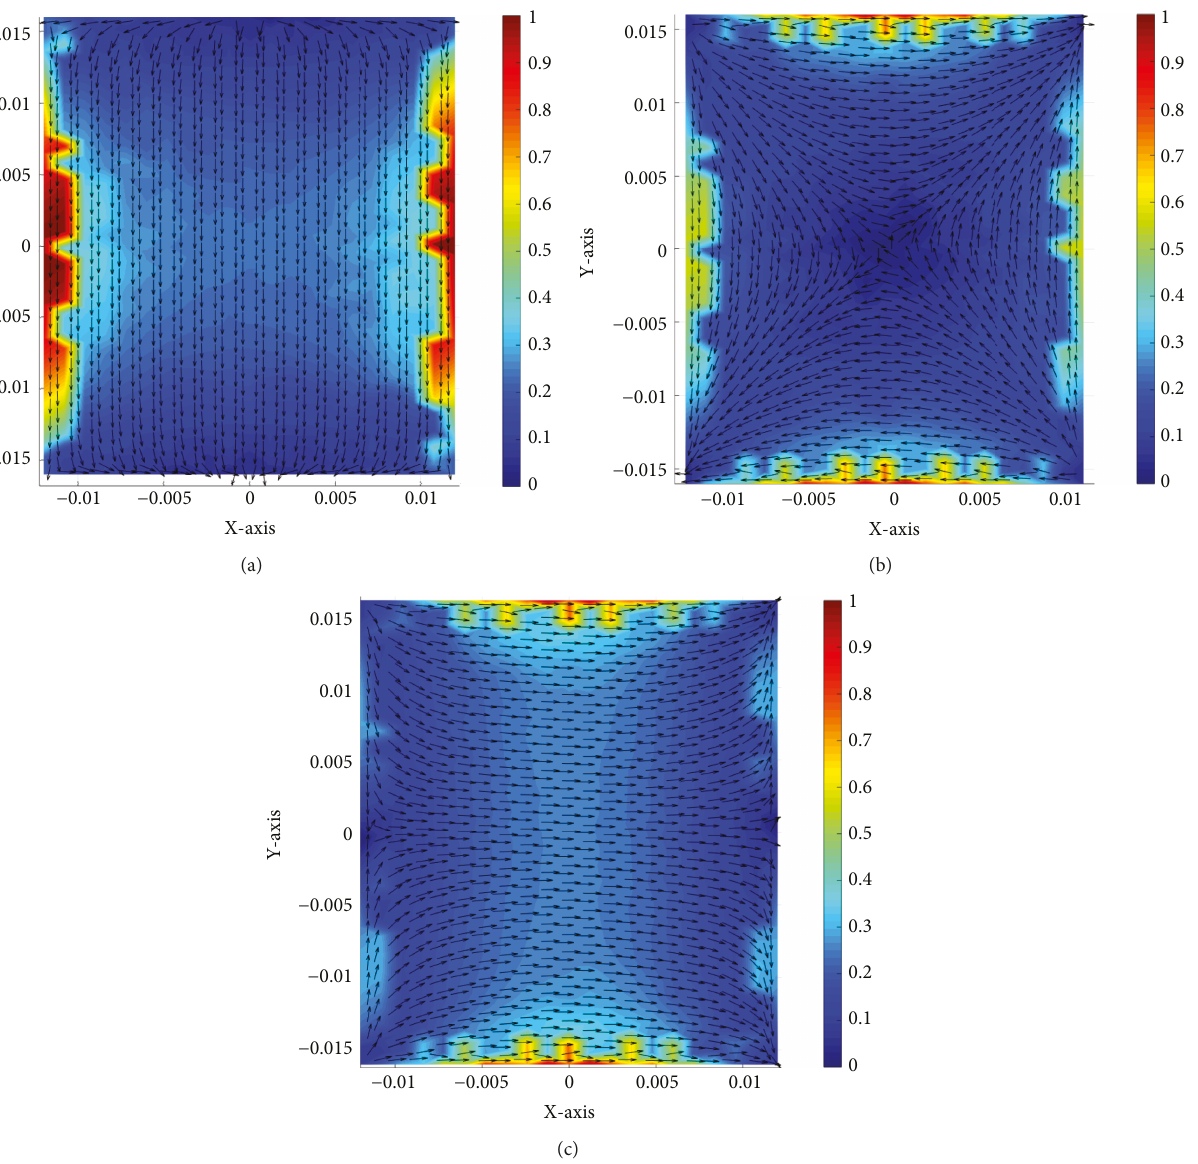
Figure 19: (a) The current distribution of CM 1 at 4.45GHz, (b) the current distribution of CM 2 at 7.01GHz, and (c) the current distribution of CM 3 at 8.50GHz. Here, the slight unsymmetry of these current distributions originates from numerical calculation